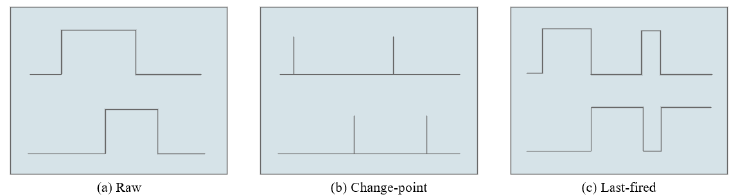
Figure 5. One of the earlier feature